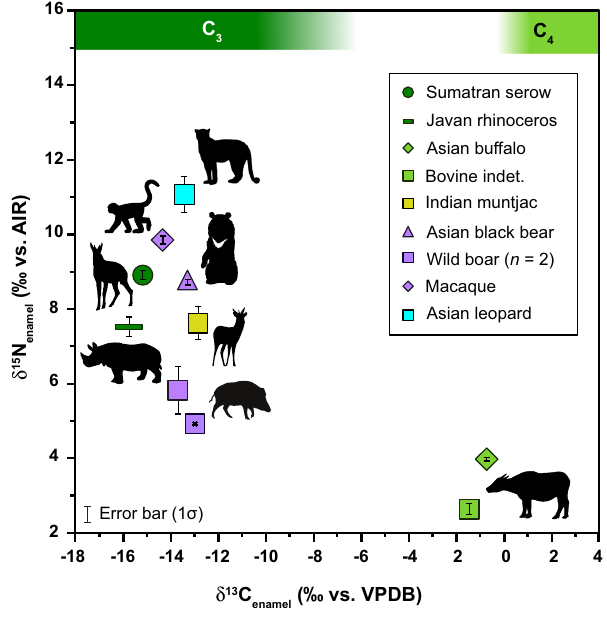
Fig. 5 Cross plot of δ 13 C enamel and δ 15 N enamel for all fossil tooth samples from Tam Hay Marklot (THM) Cave. Herbivore (browsers, dark green; grazers, light green; mixed feeder, brown-green), omnivore (purple), and carnivore (blue) taxa are indicated. One individual was measured for all taxa, with the exception of the wild boar. Green shaded bars at the top of the fi gure indicate tooth enamel δ 13 C isotopic ranges for herbivores corresponding to pure C 3 (browsing) and C 4 (grazing) resource utilization (enamel δ 13 C after Cerling et al. 104 and corrected for a fossil-fuel-induced shift in the δ 13 C atmospheric CO 2 of ~ − 2.0 ‰ 98 ). Grazing taxa are clearly distinguished from the rest of the fauna by their higher δ 13 C enamel values. Most of the THM fauna lived and foraged in predominantly C 3 habitats.